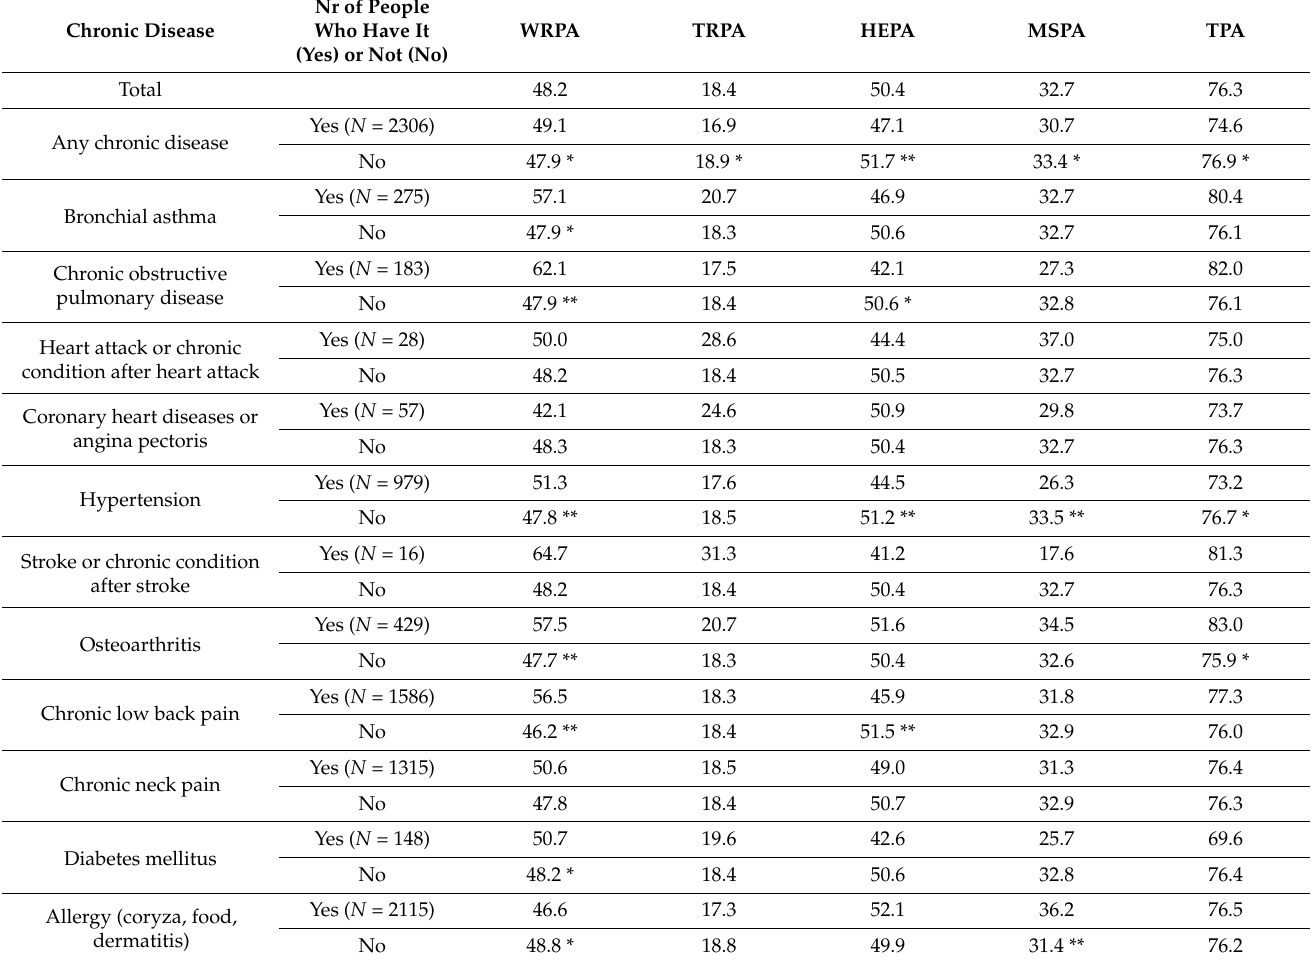
Table 3. Proportion of people who reached the respective thresholds in the different domains of physical activity in gainfully employed persons in Austria with and without specific chronic